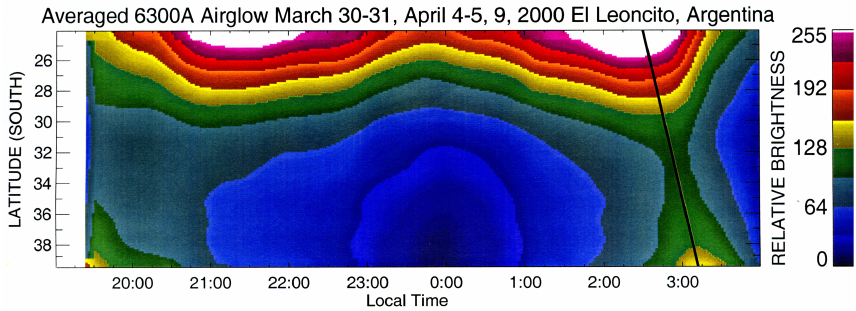
Fig. 5. Averaged meridional brightness vs. local time scan taken from 630.0nm images on the nights of 4, 5 and 9 April, 2000. The brightness wave (BW) that originates from the midnight temperature maximum (MTM) near the equator is seen to reach and exit the El Leoncito FOV between 02:00 to 03:30 LT. The black line indicates the BW poleward propagation path, showing the highest geographic latitudes reached by a BW event (Colerico et al., 2006).